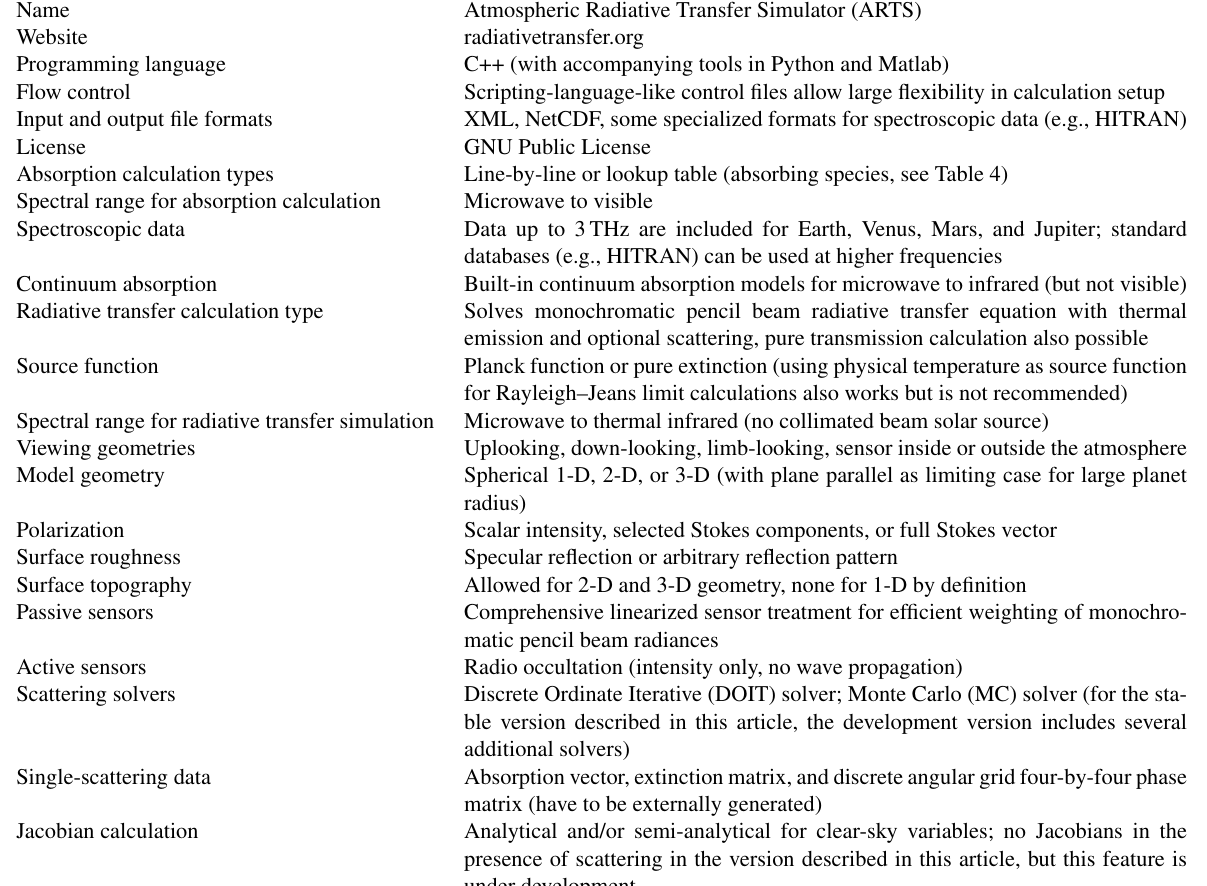
Table 1. An overview of general ARTS